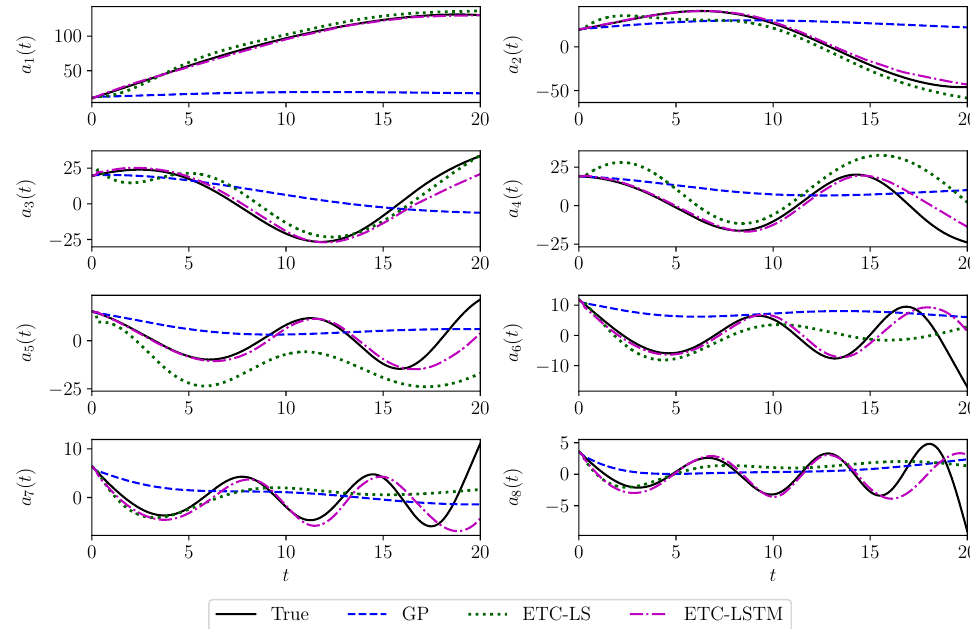
Figure 9. Evolution of vorticity modal coefficients at Re = 1000 for γ = 0.1.